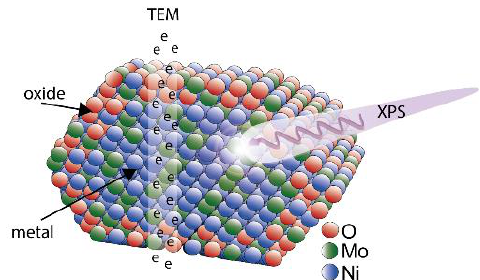
Figure 7. A schematic of the NiMo nanoparticle produced, where the high energy of the electrons in TEM-XEDS probe a cross-section of the particle, while XPS provides information of the surface. The XPS results indicate oxide formation on the outer atomic layers with a higher Ni content than in the core of the particles.